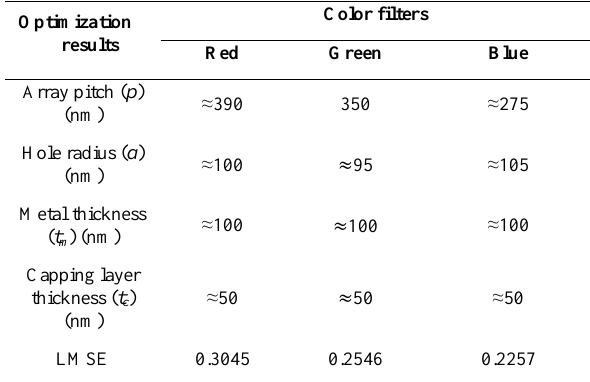
Table 1. The resultant parameters of the optimization procedure.